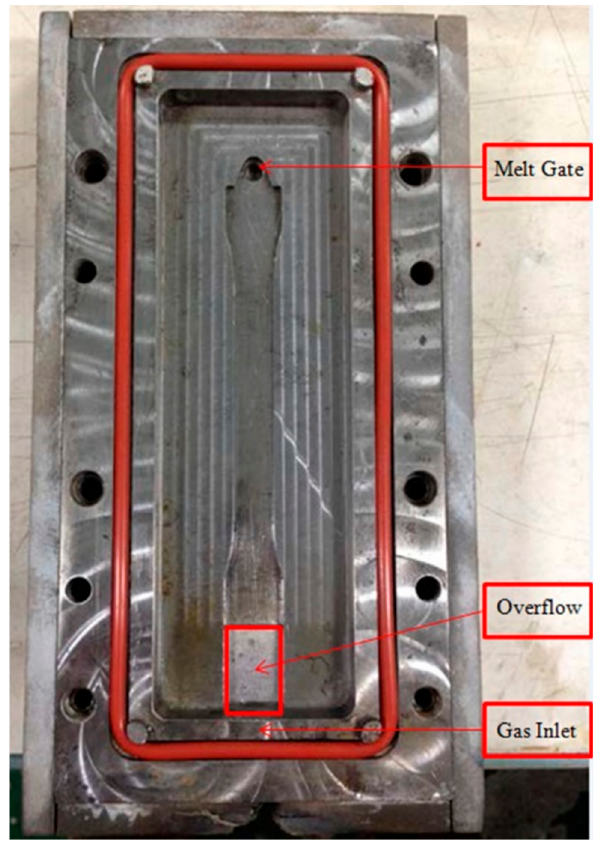
Figure 2. Cavity for gas counter pressure